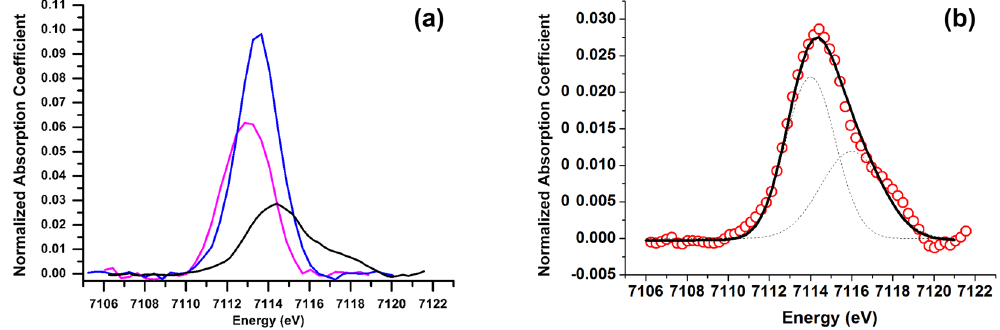
Figure 3. ( a ) Pre-edge spectra of AlkG reduced (magenta), AlkG oxidized (blue) and AlkB oxidized (black) after the subtraction from background; ( b ) the pre-edge spectrum of AlkB oxidized (red circled line) is de-convoluted into two pre-edge peak components (dashed lines) with the absorption maximum at 7114.1 eV and 7115.9 eV, respectively. The merged spectra of two component peaks (black line, 11.2 units) and the pre-edge spectrum of AlkB oxidized are